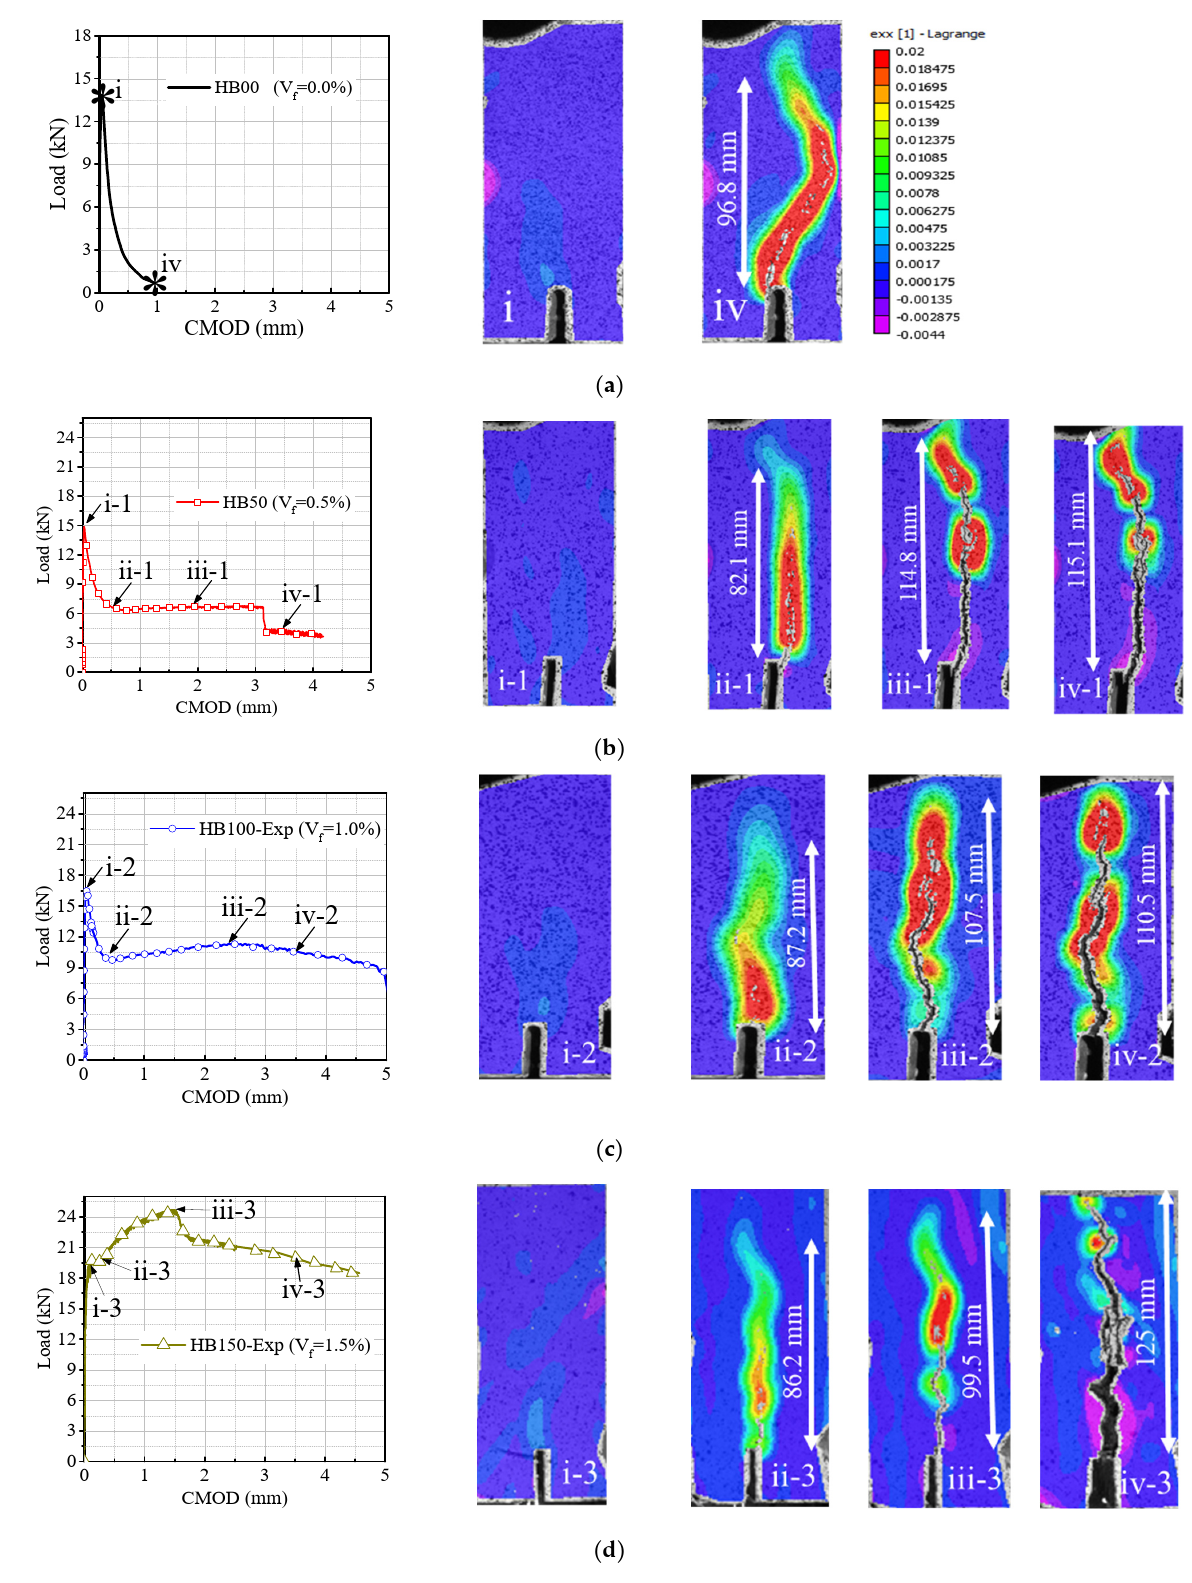
Figure 5. Load–CMOD curves with surface strain contour in x-direction of HB prisms: ( a ) HB00; ( b ) HB50; ( c ) HB100; ( d ) HB150.